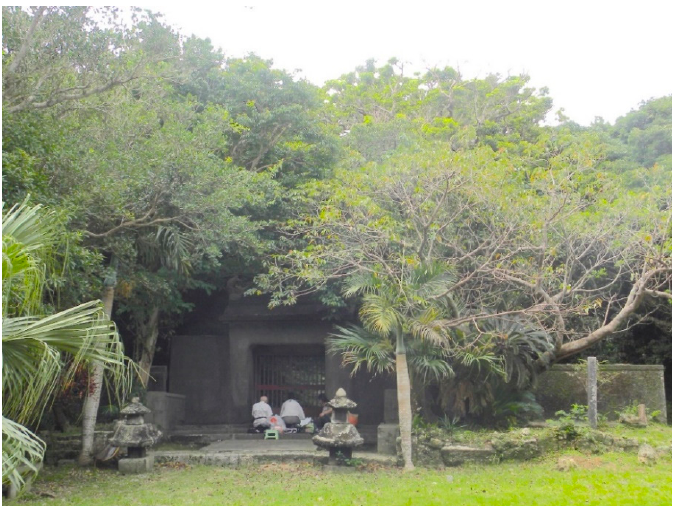
Figure 1. Worshippers making ritual offerings at Bengadake, a sacred grove on a hill near Shuri Castle, Naha.